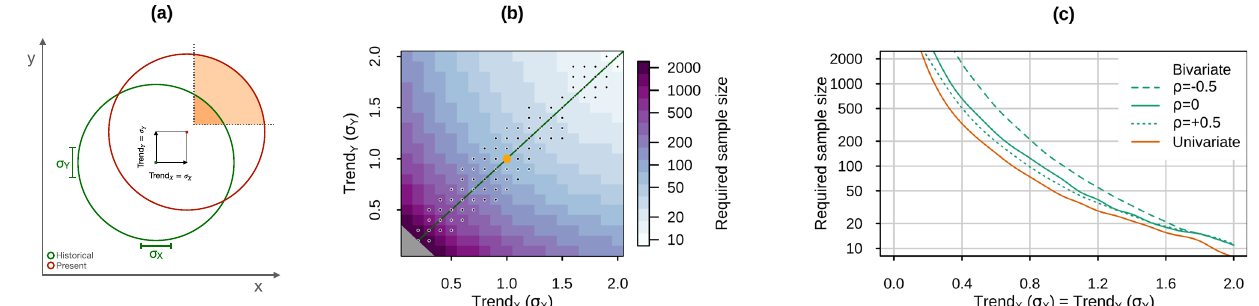
Fig. 3 | Required sample size for attribution of compound and univariate events. a Idealized bivariate distribution of two compound drivers ( X , Y ) under historical conditions (green), and under present conditions (red) obtained via shifting the mean of the historical drivers by forced trends Trend i equal to one standard deviation ( σ i ) of the historical distribution. Shading in the top-right depicts compound events, i.e. concurrent high extremes. b Minimum sample size required for attribution of concurrent high extremes (>90th percentile) of syn- thetic data simulated from a bivariate standard Gaussian distribution (with con- stantzerocorrelation)inthepresenceofpositiveforcedtrendsTrend X andTrend Y in the two drivers (expressed in units of standard deviations). Grey on the bottom